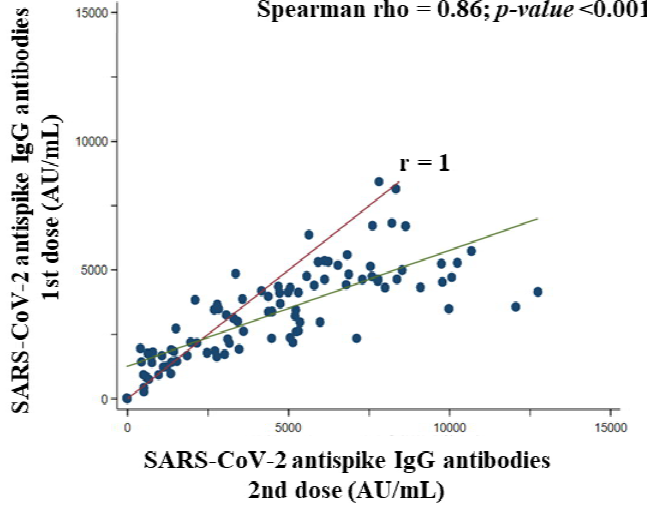
Figure 8. Correlation between SARS-CoV-2 anti-spike IgG antibody titer (AU/mL) after the first dose and after the second dose of BNT162b2 vaccine.